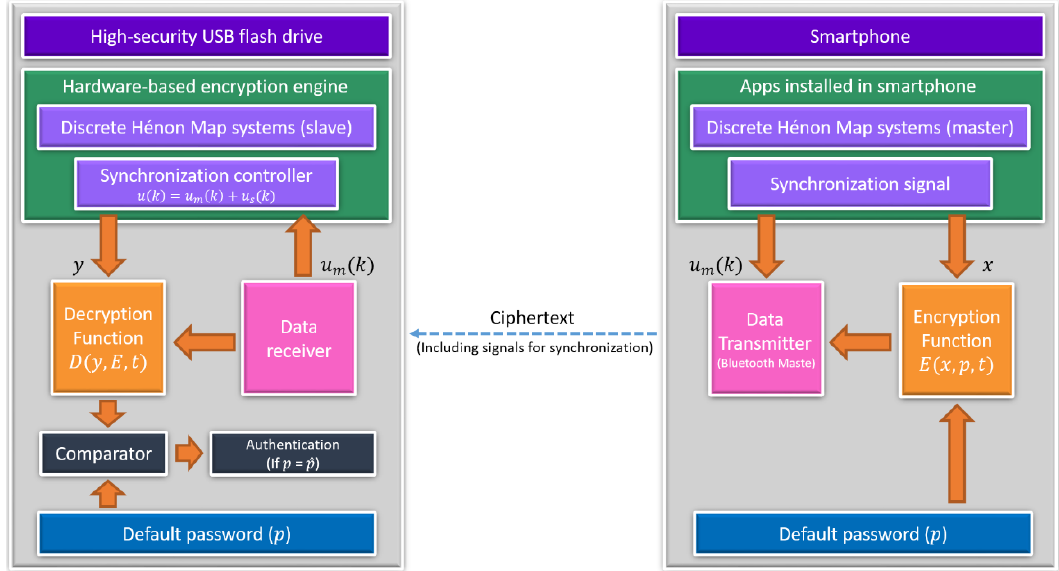
Figure 7. The authentication mechanism between USB flash drive and user’s smartphone.